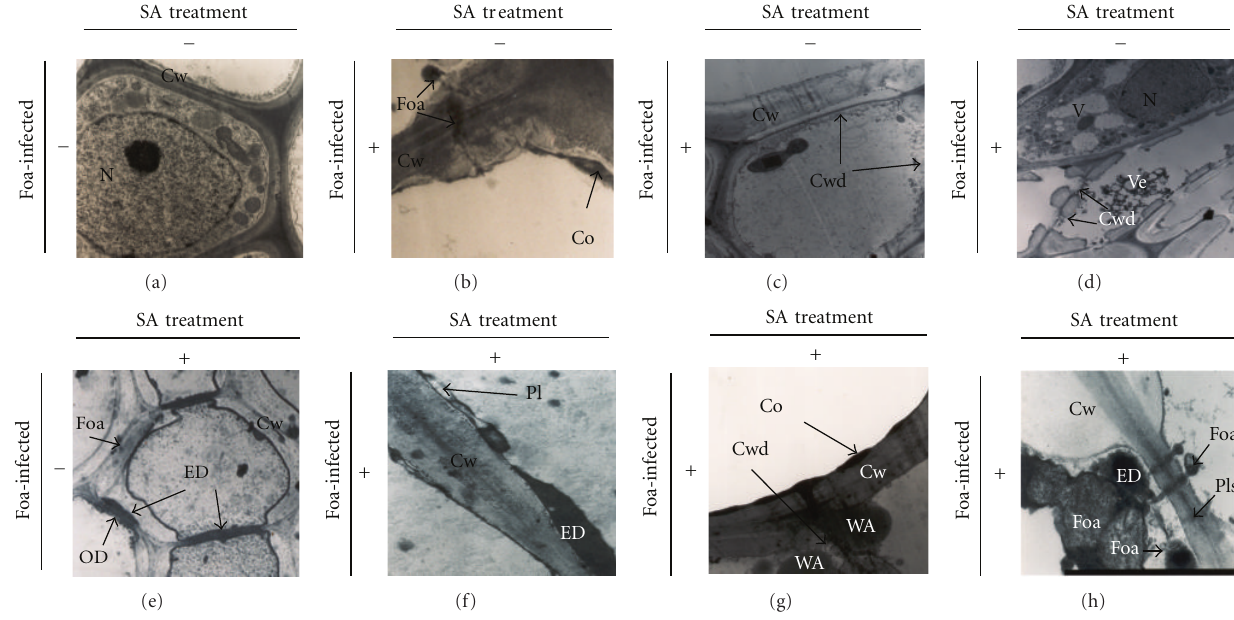
Figure 6: Transmission electron micrographs of date palm root tissues treated with SA and infected by Fusarium oxysporum f. sp. albedinis (Foa). (a: × 5000) Preserved cell wall (Cw) in control roots (UU); (b: × 20000), (c: × 6000), (d: × 5000) Untreated inoculated roots (UI); note the marked cell wall degradation (c) as well as the alteration of the cytoplasm, which was reduced to vesicular remnants (d). (e: × 6000), (f: × 12000), (g: × 12000), (h: × 30000) SA-treated and infected plants; note the accumulation of the electron-dense material (ED) (f), which forms a coat (Co) in the vessel lumen (g) and osmiophilic droplets (OD) at sites of intercellular spaces of parenchyma cells (e). Note also the wall appositions (WA) (g) and the disruption of the Foa hypha near the electron-dense material (ED) (h). Cw: cell walls; Ve: vesicles; Co: coat; Cwd: cell wall degradation; Pl: plasmalemma; Pls: plasmodesmata; N: nuclei; Foa: Fusarium oxysporum f. sp. albedinis